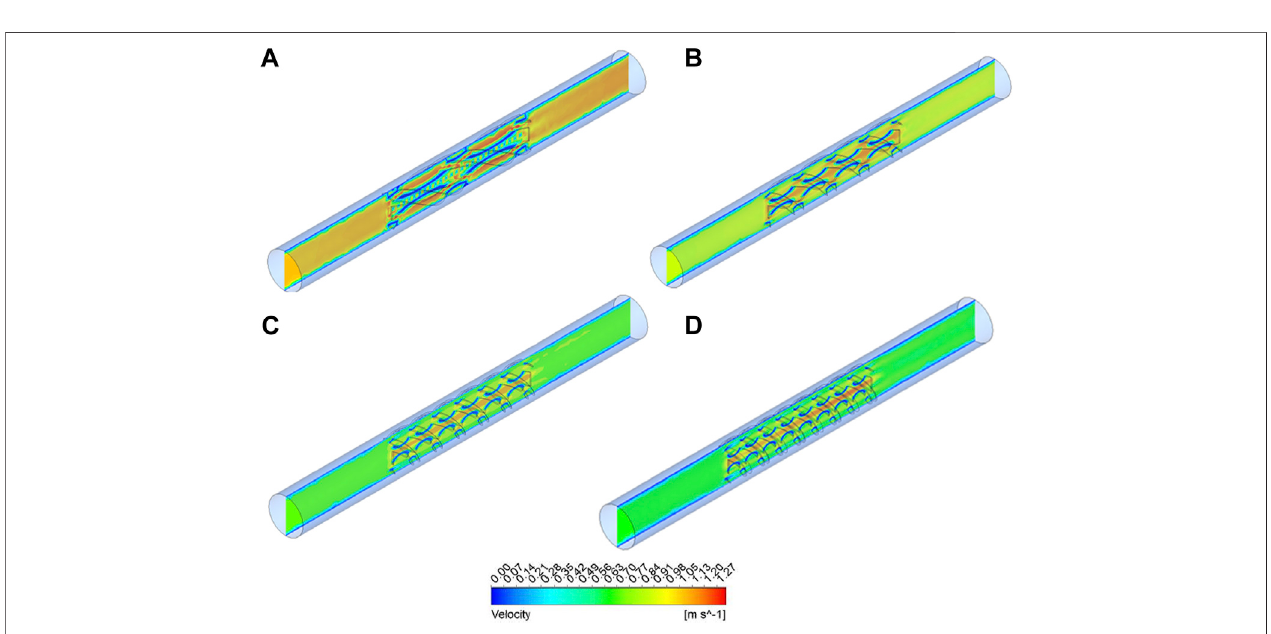
FIGURE 5 | The distribution of velocity at torsion ratios of (A) n (cid:1) 1, (B) n (cid:1) 2, (C) n (cid:1) 3, and (D) n (cid:1) 4.